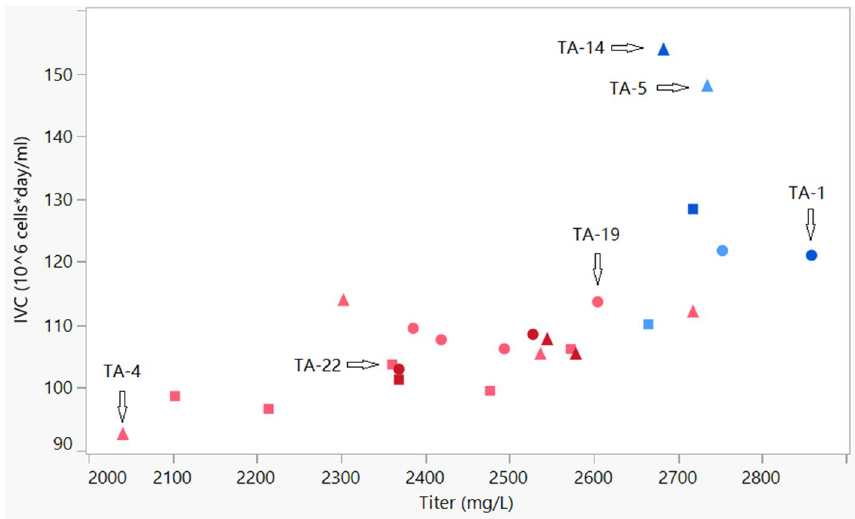
Figure 2. The scatter plotting of IVC vs. titer from 24-run experiment in Ambr. The IVC value indicated cell growth. Titer indicated the concentration of antibody when harvest. Basal medium CD14 is dot, basal medium CD 15 is square, Dynamis is triangle, FEED B is blue, PFF06 is red, galactose addition day 12 is light color and day 13 is dark color. The image was created by JMP V15 (http:// www. jmp. com).